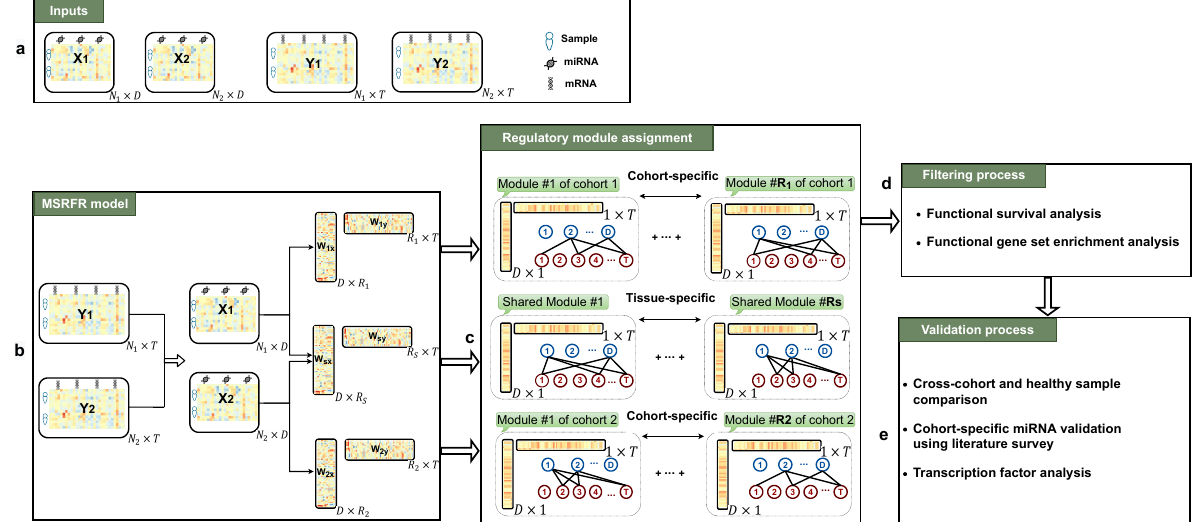
Figure 1. Overview of the developed framework for identifying key tissue-specific and cohort-specific regulatory modules of two cancer types from the same origin. ( a ) Input data that includes miRNA and mRNA expression profiles of two cancer cohorts. ( b ) Imposing low-dimensional structure and multitask learning formulation simultaneously to identify cohort-specific regulatory modules of two cancer types and shared regulatory modules between them (i.e., tissue-specific), as well as effective estimation of the number of each regulatory module (i.e., R 1 , R 2 , and R s ) using MSRFR model. ( c ) Writing the low-rank matrices as the summation of R 1 , R 2 , and R s rank-one matrices such that each of them corresponds to one miRNA–mRNA regulatory module of first cancer cohort, second cancer cohort, and tissue-specific regulatory modules. ( d ) Filtering identified regulatory modules to test for key modules with biological relevance and functional importance by applying functional survival and gene set enrichment analyses. ( e ) Validating the result of the experiment, first by comparing the result of the study against cross-cohort and healthy sample result to examine the uniqueness of identified modules, then by literature validation of identified miRNAs in cohort- specific regulatory modules to see whether they are related to the underlying disease, and finally by assessing the transcription factor expression in identified